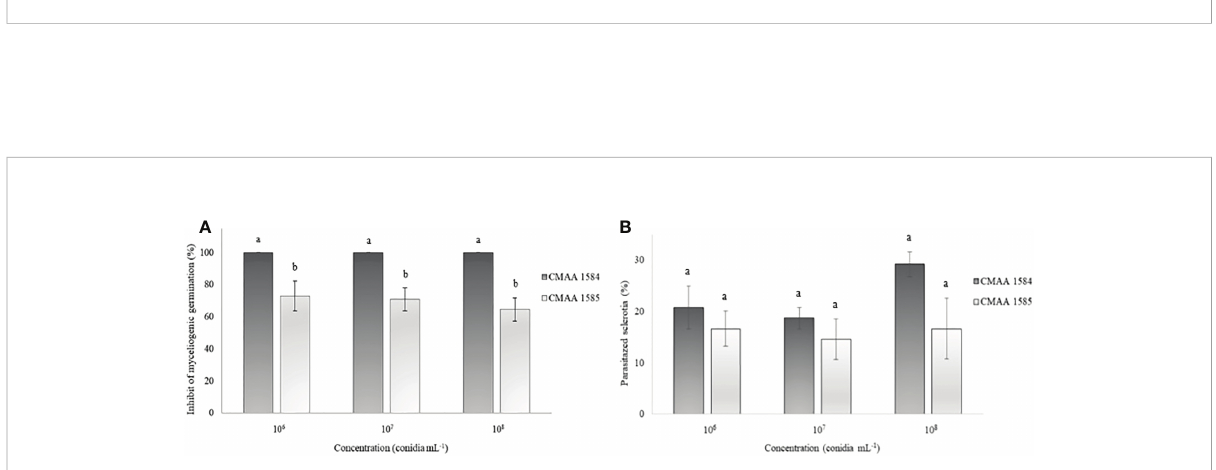
FIGURE 2 Biocontrol potential of Trichoderma asperelloides CMAA 1584, and Trichoderma lentiforme CMAA 1585 strains against Sclerotinia sclerotiorum according to Bell scale (Bell et al., 1982). Bars indicate means (± standard error).